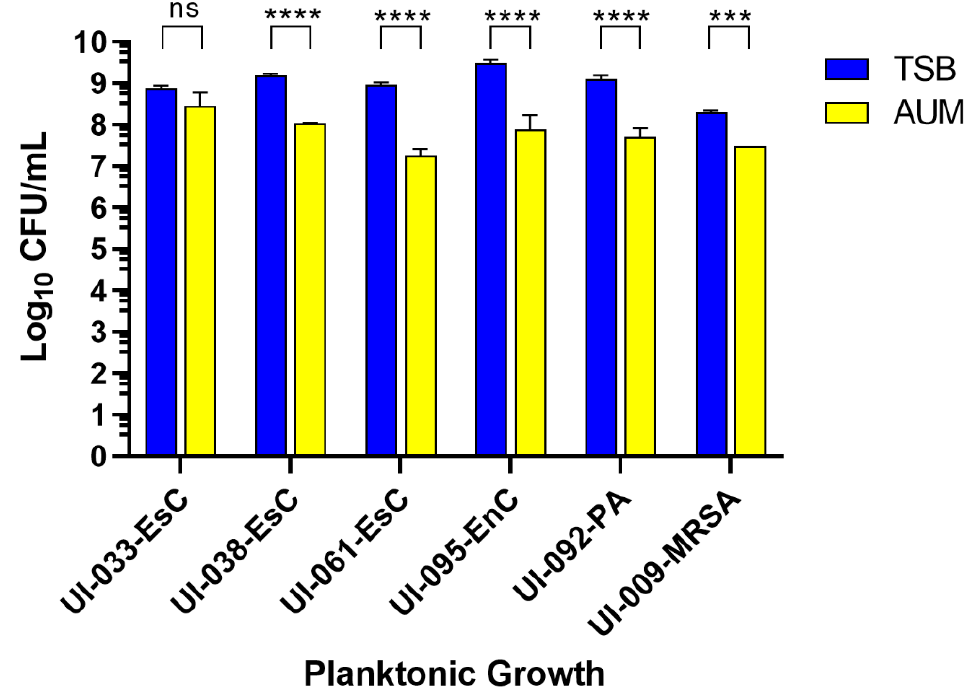
Figure 2. Artificial urine medium supports the growth of clinical uropathogens. Clinical isolates were grown in the microtiter plate assay to assess planktonic growth in tryptic soy broth (TSB) or artificial urine medium (AUM). Colony-forming units (CFU) were determined after 24 h at 37 ◦ C. Data were transformed to log 10 before graphing. Bars represent the average of three independent experiments ± SEM; ns, no significance; ***, p < 0.001, ****, p < 0.0001.